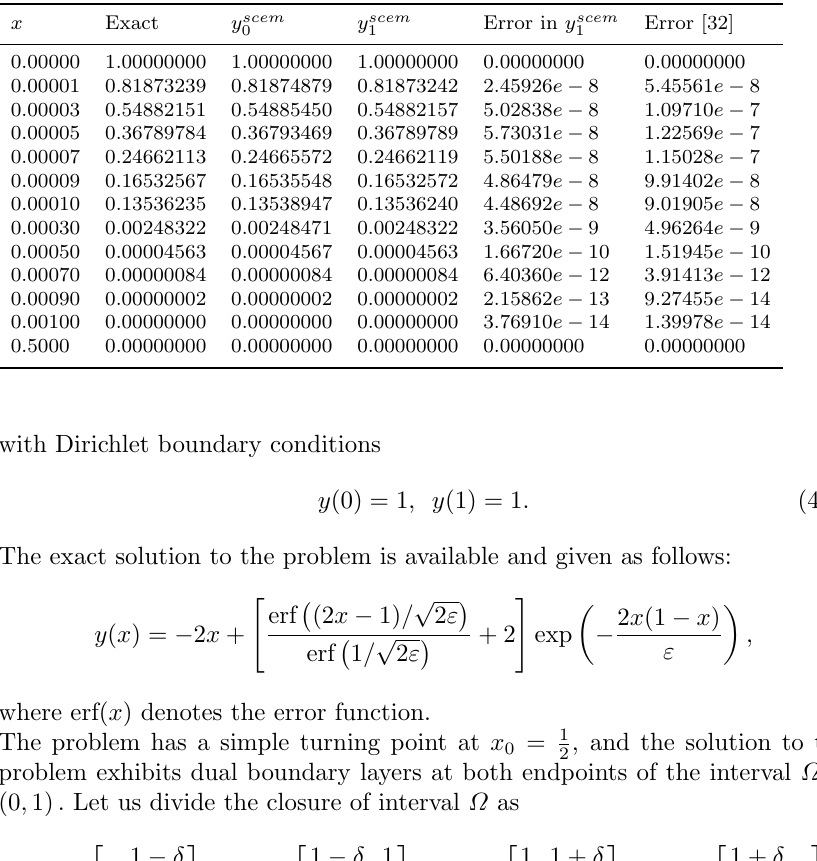
Table 2. Comparison of the analytical solutions and SCEM approximations for solving Equations (4.1)–(4.2); ε = 0 .